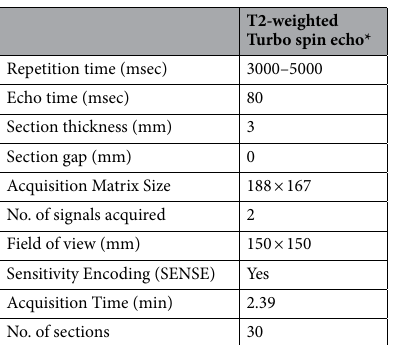
Table 1. MRI protocol parameters. *MRI parameters are referred to axial T2-weighted images.